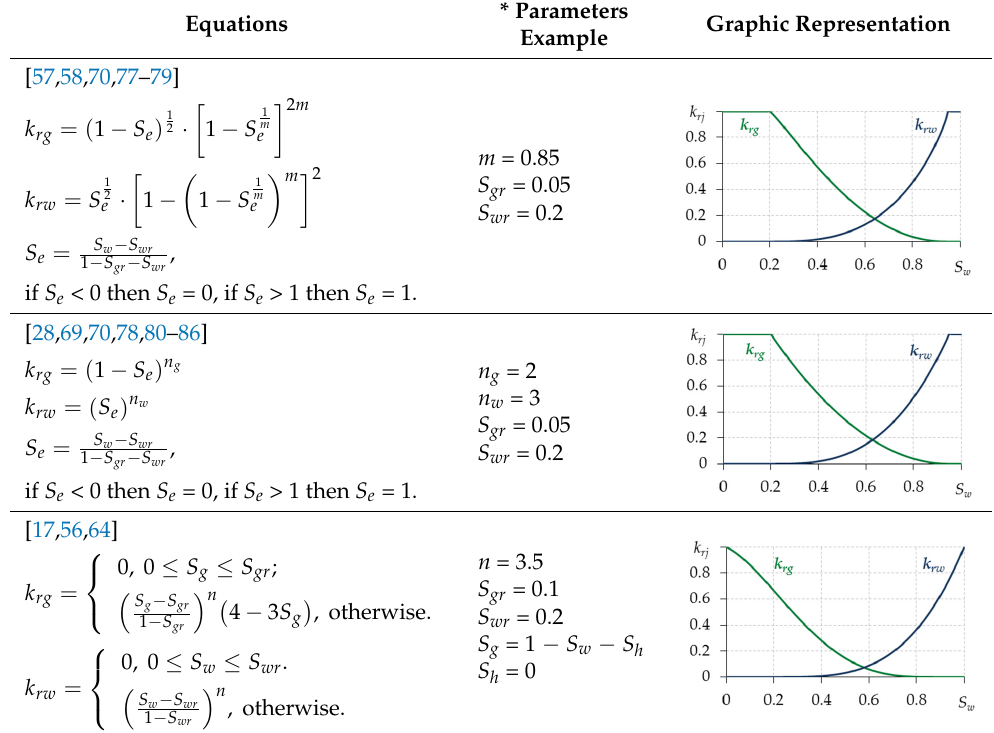
Figure 4. Permeability of a hydrate-containing porous medium as a function of hydrate saturation at various values of the exponent N [58]. Table 1. Calculation of relative permeabilities for gas and water. Graphic Representation Equations Example * Parameters